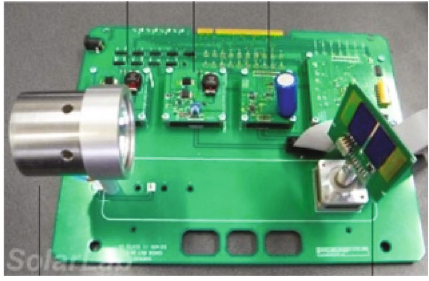
Figure 6: NI-ELVIS